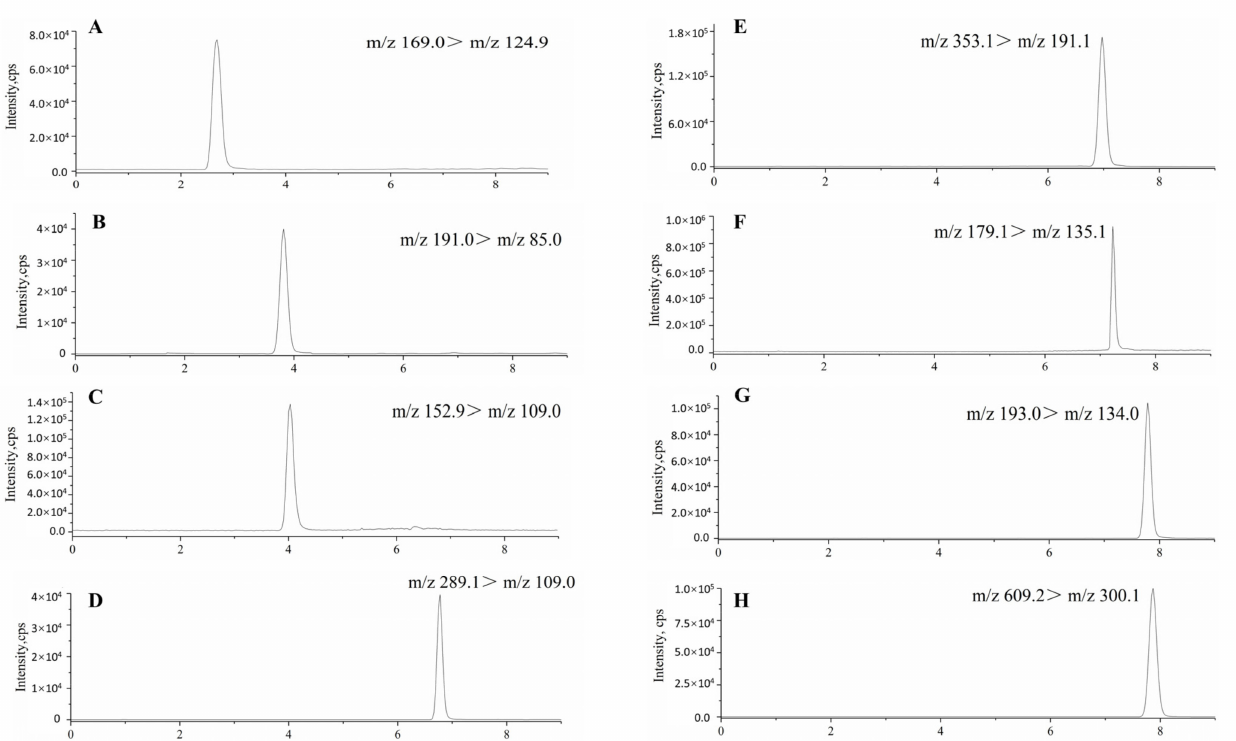
Figure 1. MRM chromatography of gallic acid ( A ), quinic acid ( B ), protocatechuic acid ( C ), cate- chin ( D ), chlorogenic acid ( E ), caffeic acid ( F ), ferulic acid ( G ), and rutin ( H ) was spiked at 10 ng/mL concentration in methanol